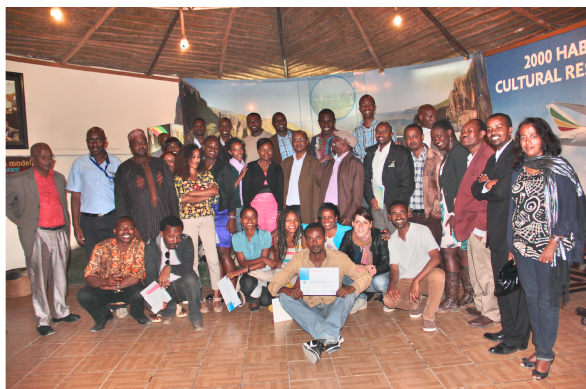
Figure 4. Participants of the first summer school held in Africa (Addis Ababa, Ethiopia) in 2013.